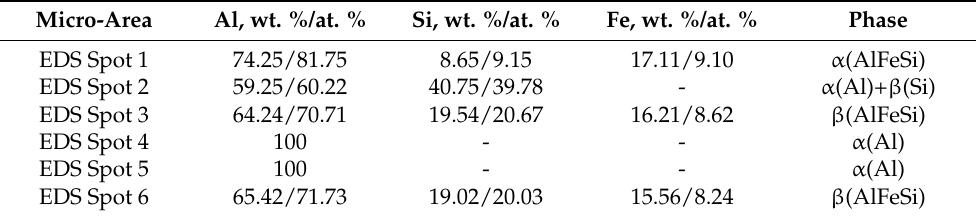
Table 3. EDS-determined quantitative chemical compositions of micro-areas, weight and atomic percentage.